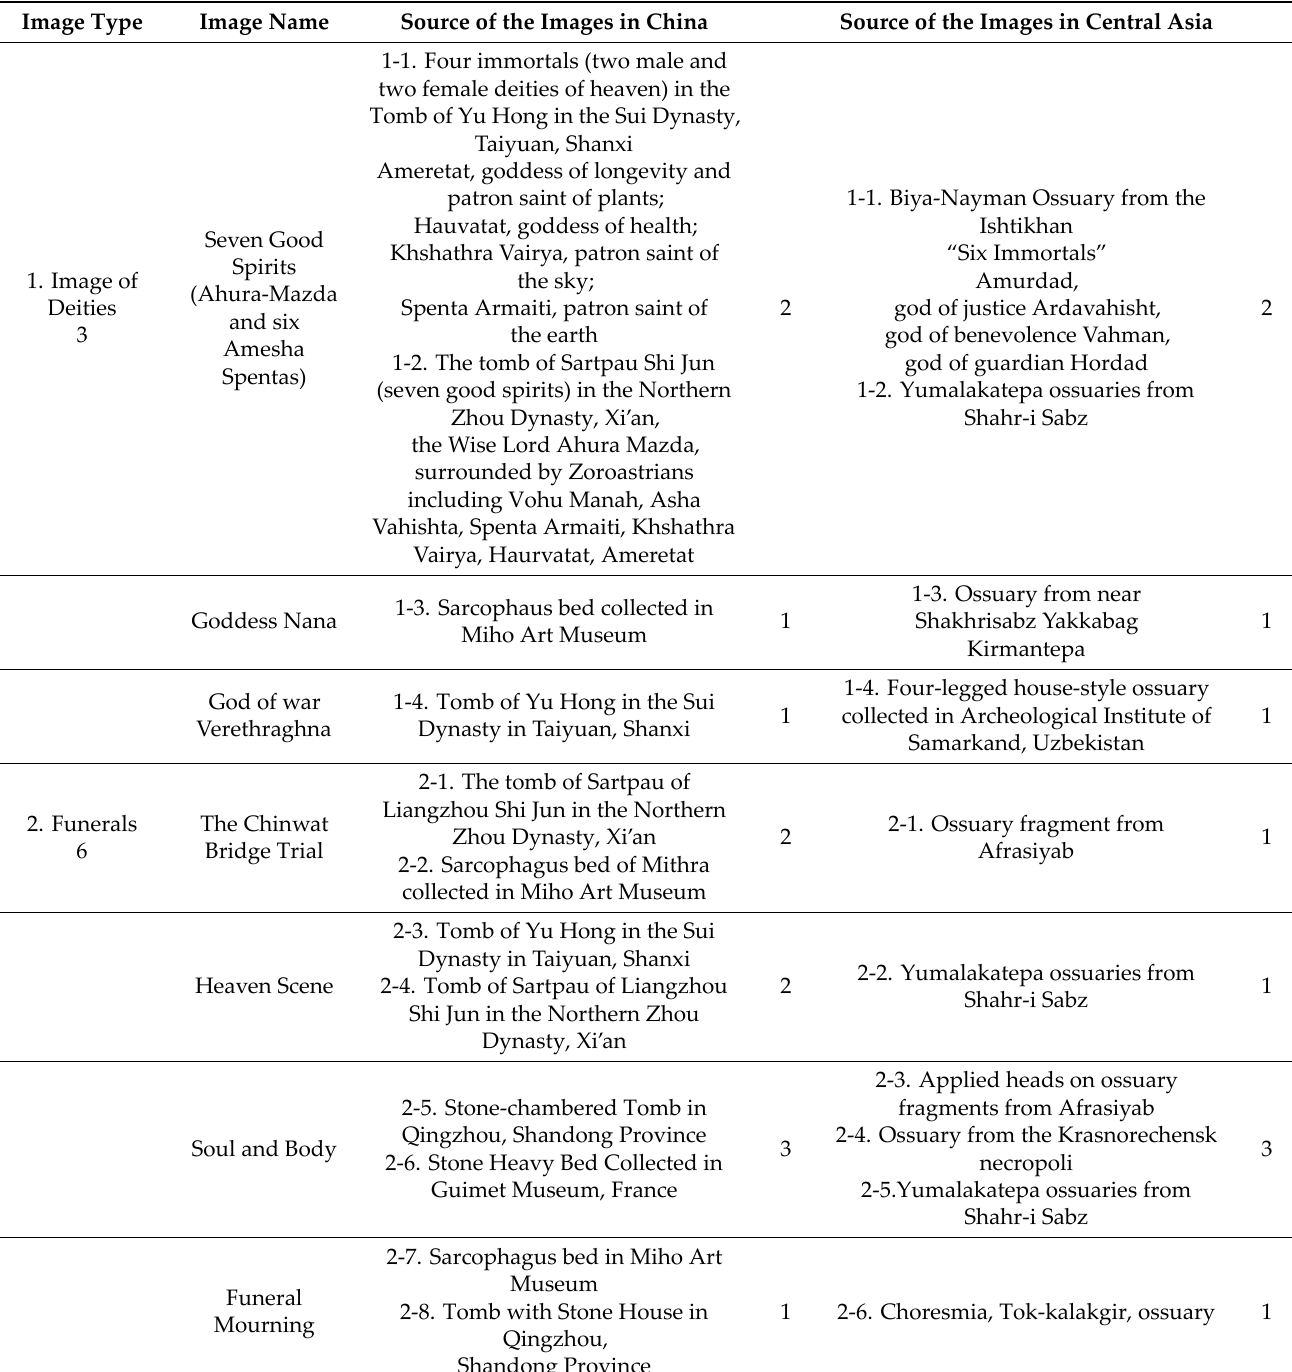
Table 6. Common Religious Images of the Burial Utensils in China and Central